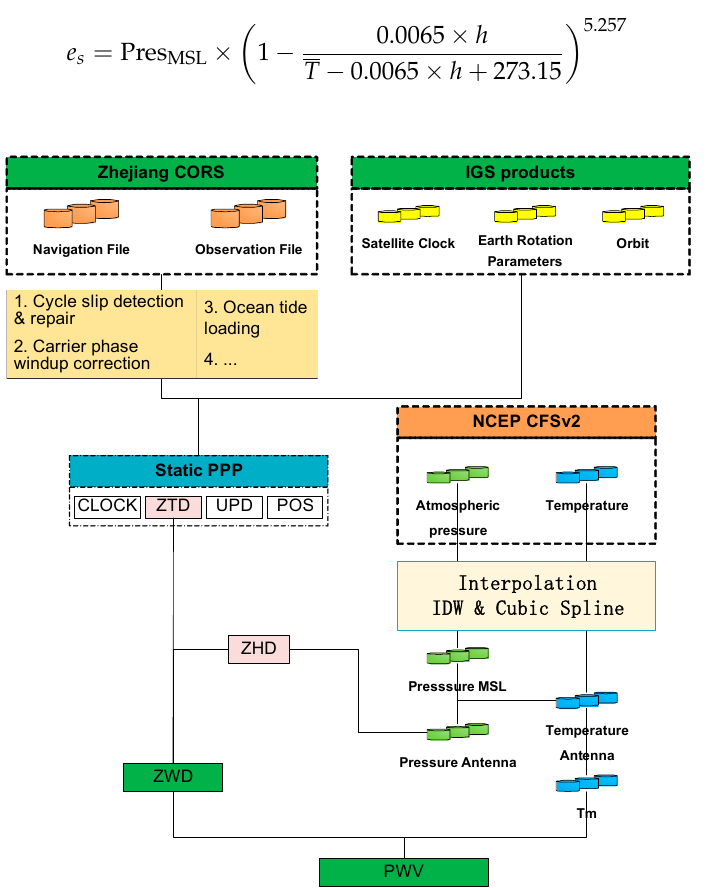
Figure 2. Flowchart for PWV retrieval from GPS PPP and NCEP sCFSv2 dataset. IGS—International GNSS Services; ZTD—zenith total delay; ZHD—zenith hydrostatic delay; ZWD—zenith wet delay; IDW—inverse distance weighted; UPD—uncalibrated phase delay; POS—position; MSL-mean sea level.